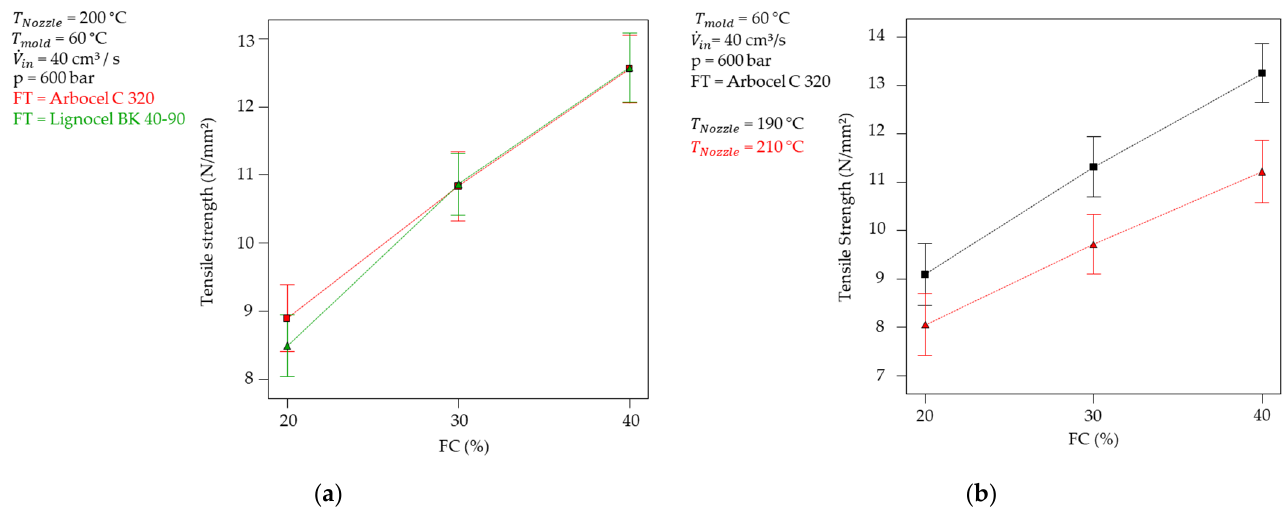
Figure 3. ( a ) Tensile strength of wood ‐ filled TPU as a function of fiber content and fiber type. ( b ) Tensile strength of wood ‐ filled TPU in dependence of temperature control.